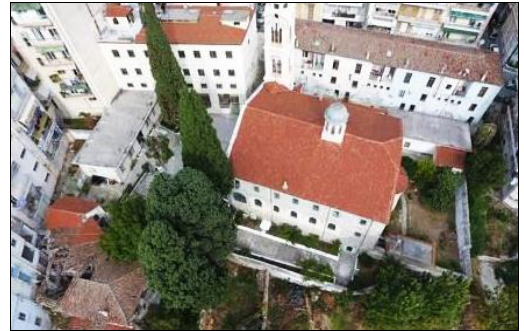
Figure 1 . Τhe historical complex of Saint John, the Baptist, as seen from above.